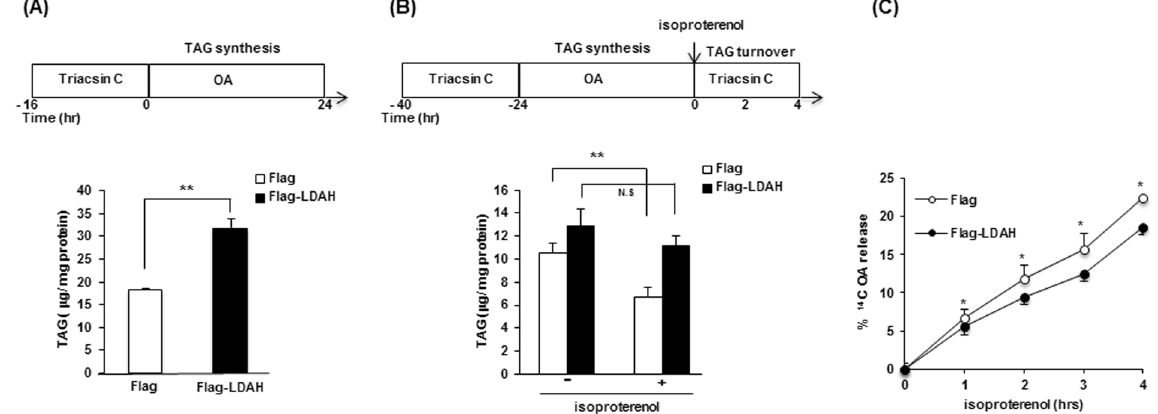
Figure 5. LDAH increases TAG synthesis and decreases TAG hydrolysis. HEK293 cells were transfected with Flag or with Flag-LDAH. Cells were synchronized with triacsin C (1 μ g/ml) for 16 h in delipidated media, followed by treatment with OA for 24 h in the absence of triacsin C. ( A ) Intracellular TAG levels were determined and normalized to protein. ** p < 0.005. ( B ) TAG hydrolysis was induced by incubation with isoproterenol (10 μ M) for 2 h in the presence of triacsin C. TAG content was measured and normalized to protein. Two-way ANOVA showed that both LDAH and isoproterenol affect TAG levels. However, the effect of isoproterenol depends on whether LDAH is present, being significantly reduced at p = 0.002 in control-transfected cells but not significantly reduced (p = 0.064) in cells overexpressing LDAH. Relevant pairwise comparisons are showed in the Figure. ** p < 0.005; N.S. = not significant. ( C ) Cells were loaded with 14 C-labeled OA following the protocol outlined in panel B, the amount of OA released to the culture media following isoproterenol (1 μ M) treatment was determined by scintillation counting. The data represents the % of OA released relative to the total amount of OA (intracellular + extracellular). * p <